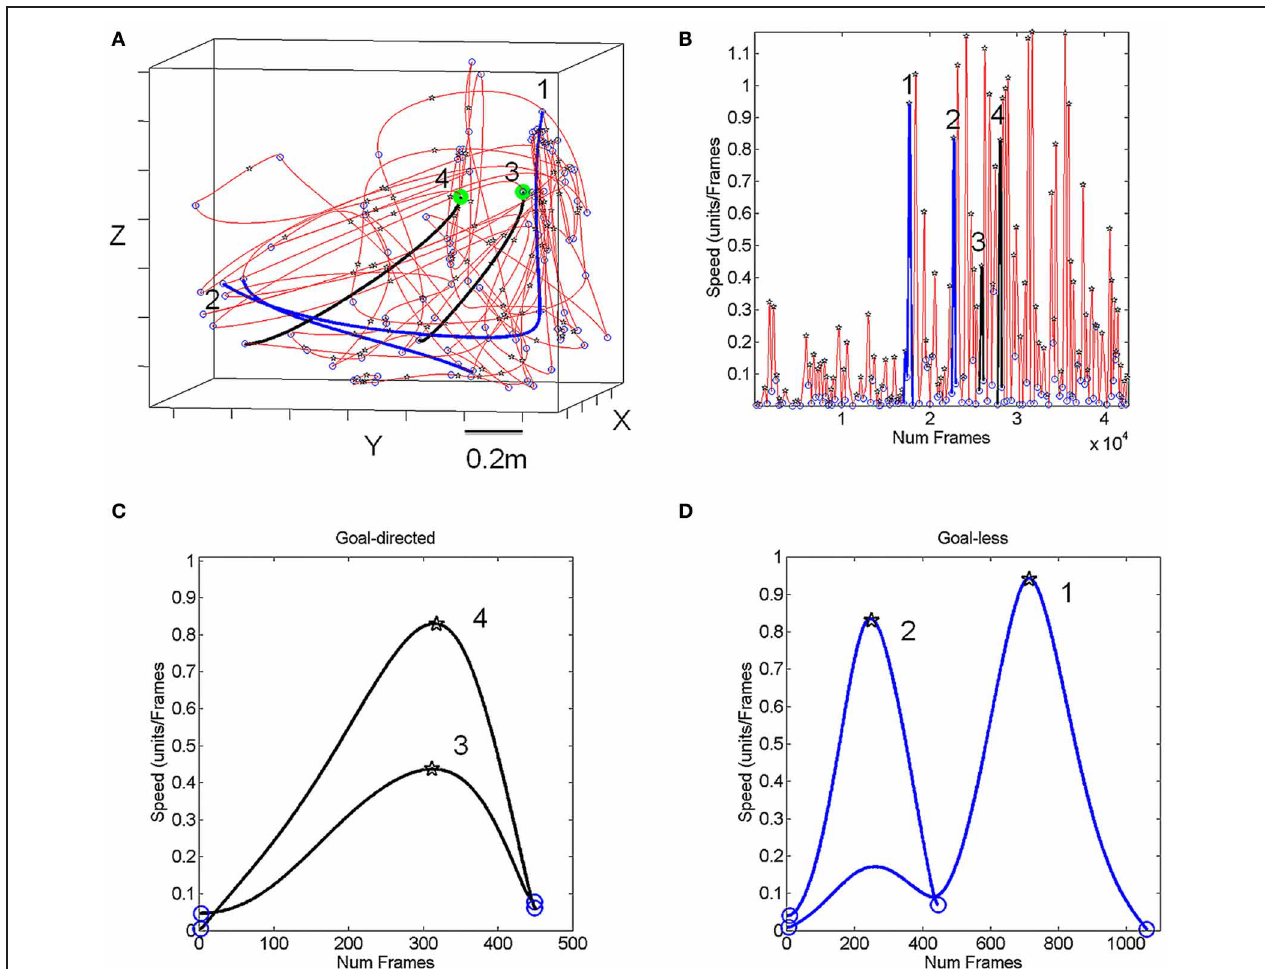
FIGURE 4 | Navigating through the continuous flow of natural motions and separating goal-directed from goal-less segments of behavior. (A) Hand movement trajectories from a typical child collected during 16.7s of the match-to-sample task (at 240 frames/s) which required deciding between two stimulus choices. The blue circles mark the speed minima (pauses) while the black stars mark the speed maxima. The black curves denote the pointing trajectories to the green target at two different positions on the monitor facing the child. The